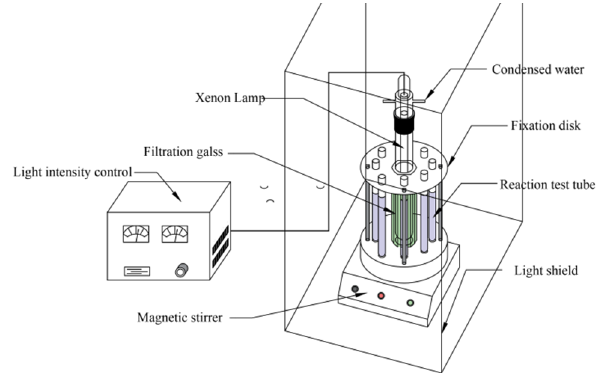
Figure 11. Schematic diagram of the photocatalysis experimental device.